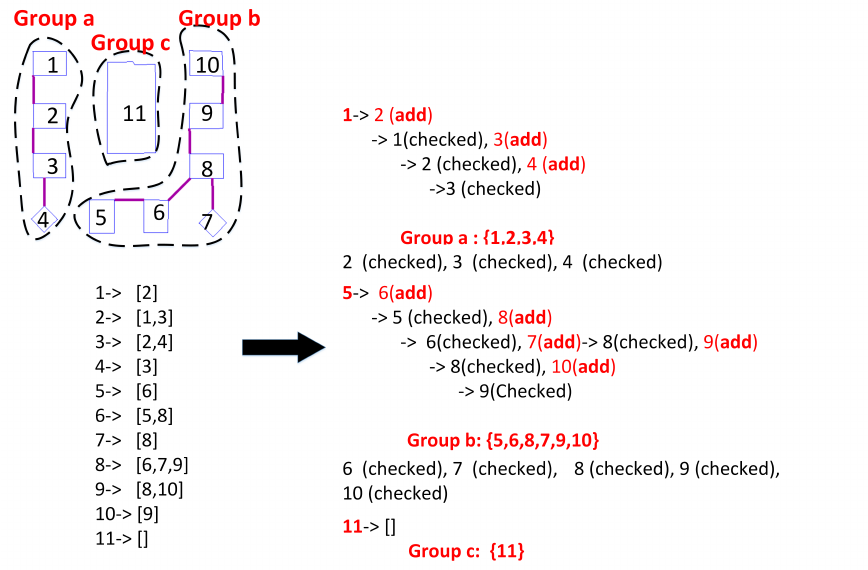
Figure 7. Grouping 11 obstacles into three groups with respect to the